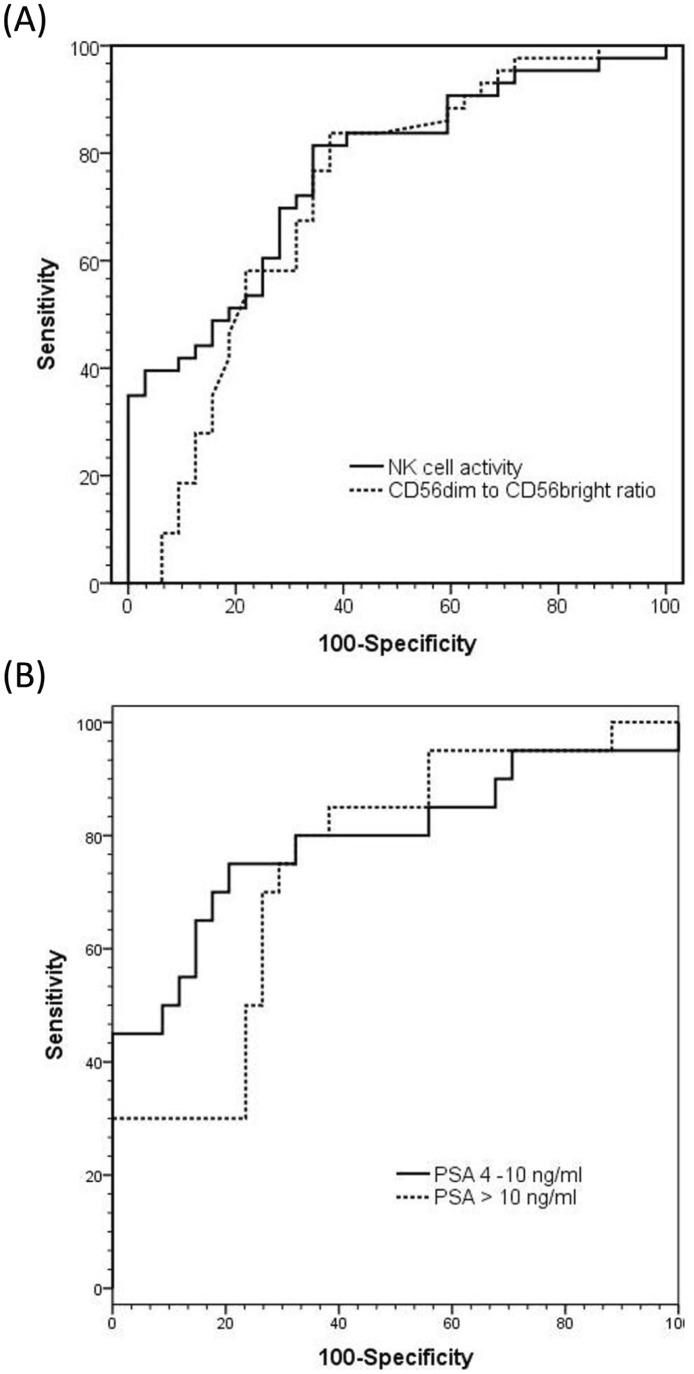
(A) ROC curves comparing the performances of NK cell activity and CD56dim-to-CD56bright ratio measurements.(AUC = Area Under the Curve). (B) ROC curves comparing the performances of NK cell activity measurement according to PSA grouped as; 4 to 10 ng/ml and greater than 10 ng/ml. (AUC = Area Under the Curve).